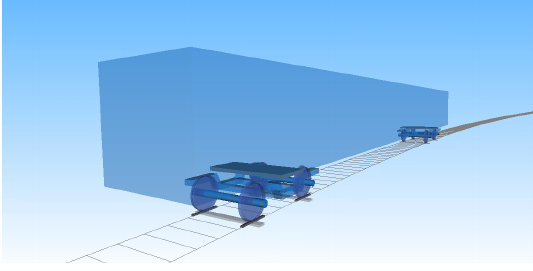
Figure 2. The vehicle model created in